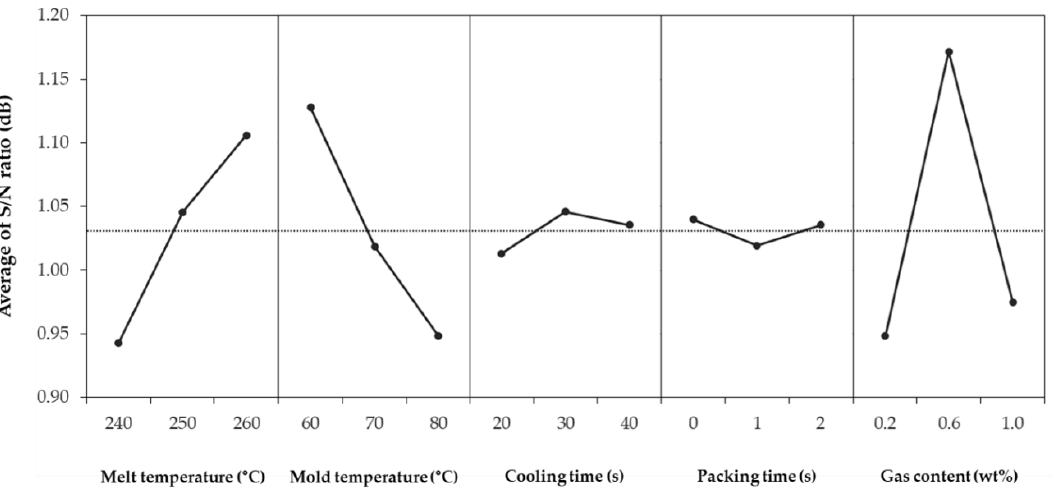
Figure 5. Average of S/N ratio for shrinkage in the transverse direction.